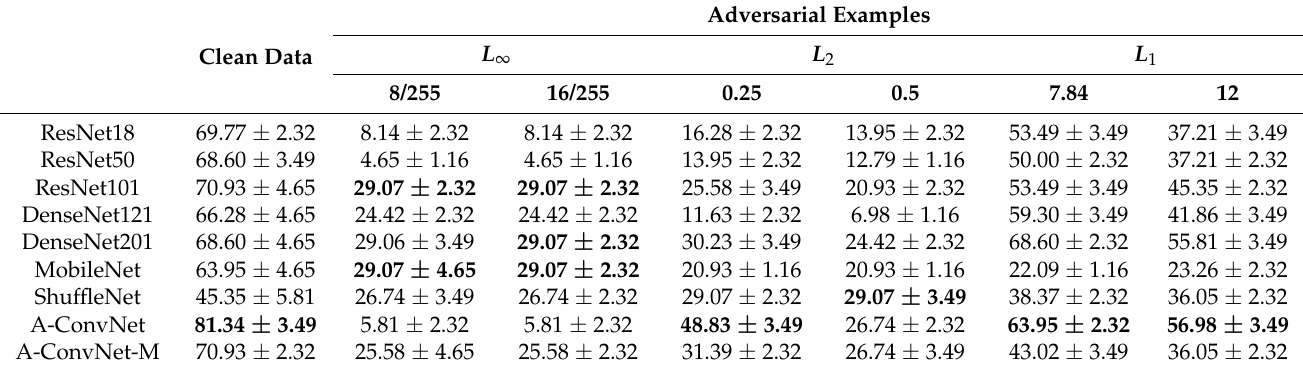
Table 4. Classification accuracy of FUSAR-Ship models against standard adversarial attack (PGD).